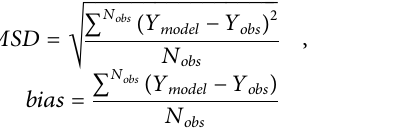
Frontiers in Earth Science |